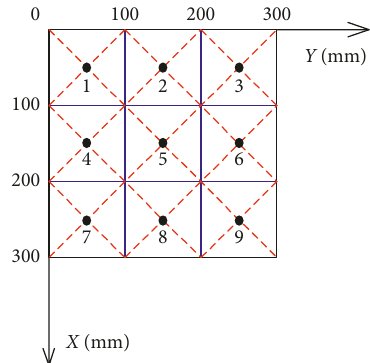
Figure 6: Schematic diagram of the broken lead